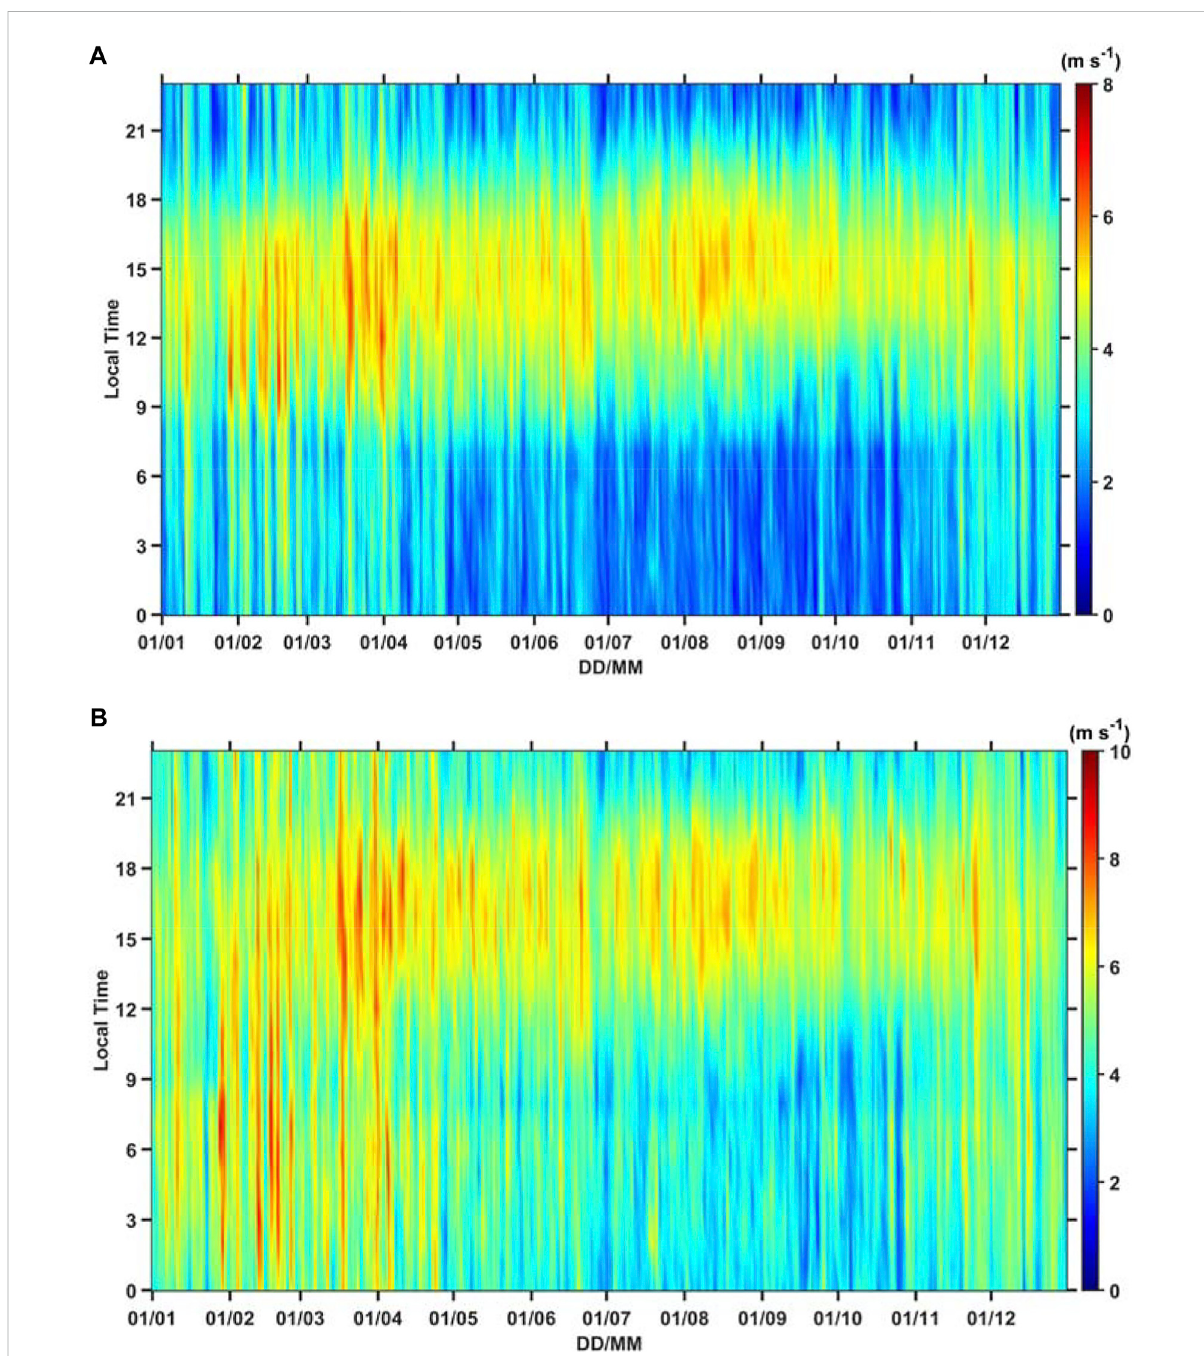
FIGURE 4 Diurnal cycle averaged over 2012 – 2019 for all days of the year for horizontal wind speed (m s − 1 ) at 10 m (A) and 60 m (B) above ground level. The corresponding wind direction plots are given in Supplementary Figures S1,